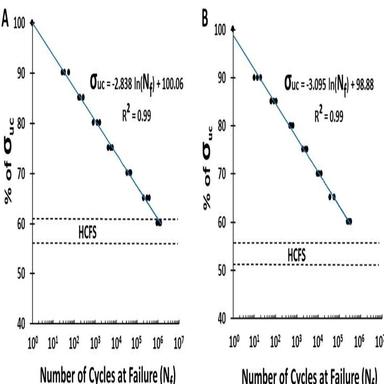
Conventional fatigue testing results for compressive σ-Nf graphs. (A) Type A configuration where σuc = 261.7 MPa, (B) Type B configuration where σuc = 231.9 MPa. Applied stress ratio was R = σmin/σmax = 0.1. Cycling frequency was 5 Hz. HCFS ranges are between dashed lines for 1 and 5 million cycles.